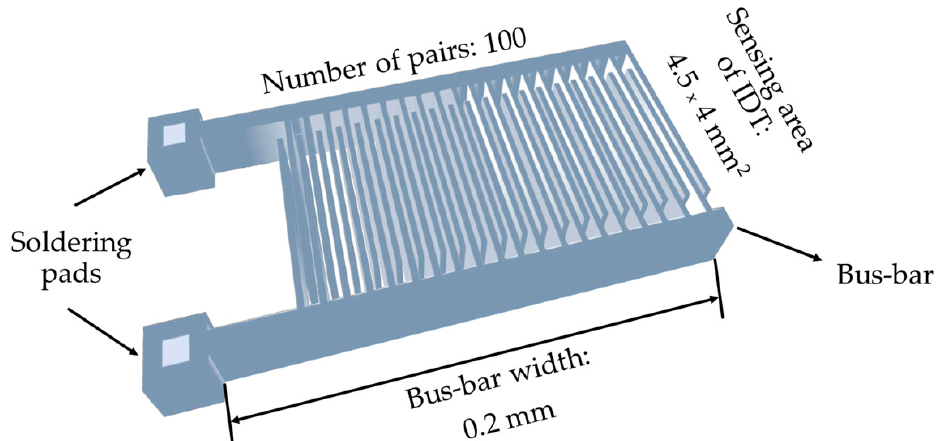
Figure 2. The layout of the sensing structure (the distance between the metallic interdigitated (IDT) dual-comb structure fingers is 10 µm).